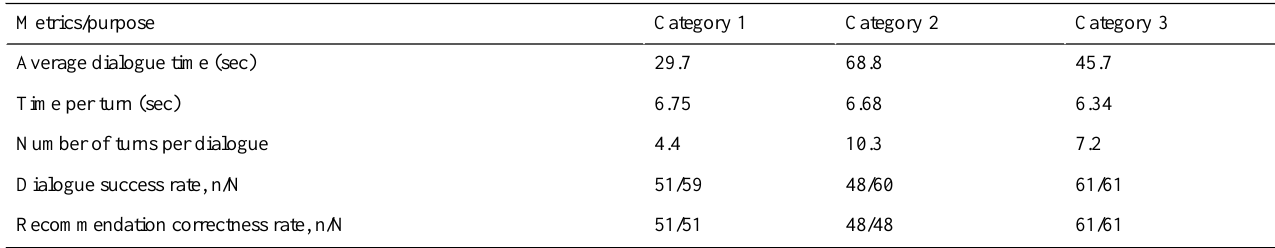
Table 1. Dialogue performance